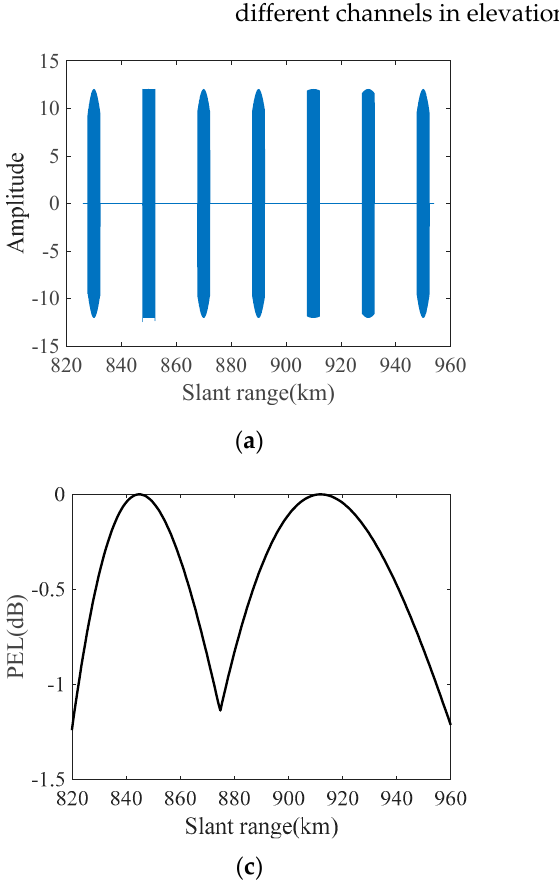
Figure 5. Simulation results processed by the DBF processor with the multi-group time delays. ( a ) Real part of echoes handled by the improved DBF processor with two-group time delays. ( b ) Real part of echoes handled by the improved DBF processor with four-group time delays. ( c ) Residual PEL in ( a , d ). Residual PEL in ( a , b ).